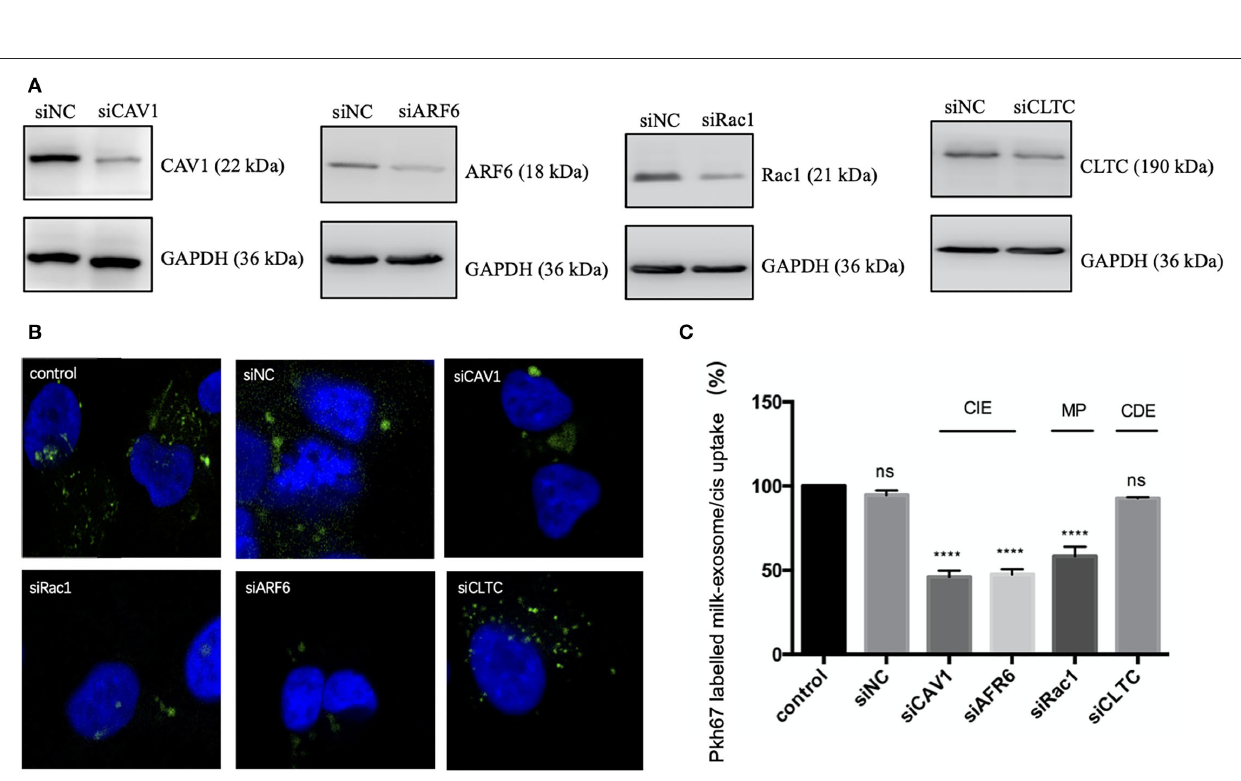
Frontiers in Medicine |